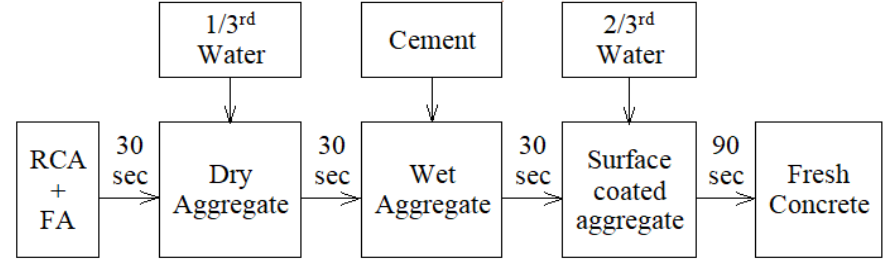
Figure 3. Two-stage mixing